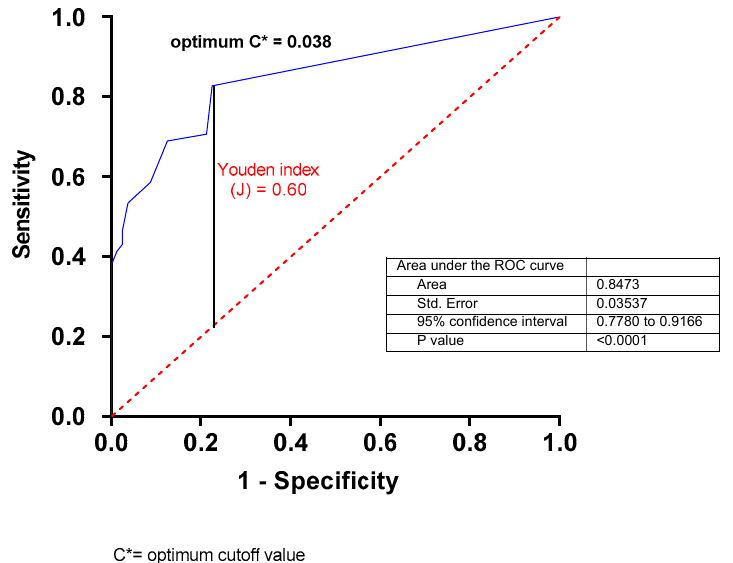
Figure 3. Receiver operating characteristic (ROC) curves exhibiting the discriminatory power of sdLDL. C*: optimum cutoff value of ACS determined using the maximum Youden index (J) [(sensitivity + specificity) − 1 = 0.60].